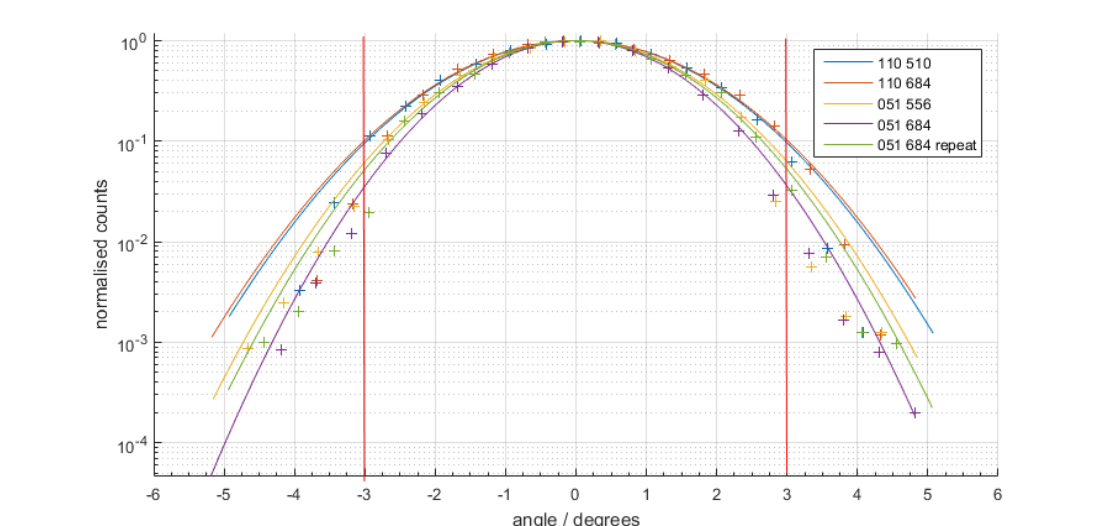
Figure 8. Measurement results to confirm the FOV of the transfer radiometers being used in the FRM4SOC radiance round robin presented on logarithmic scale. The vertical bars indicate ± 3 ◦ . The numbers in the plot legend refer to the radiometer serial number and the spectral band (in nm)